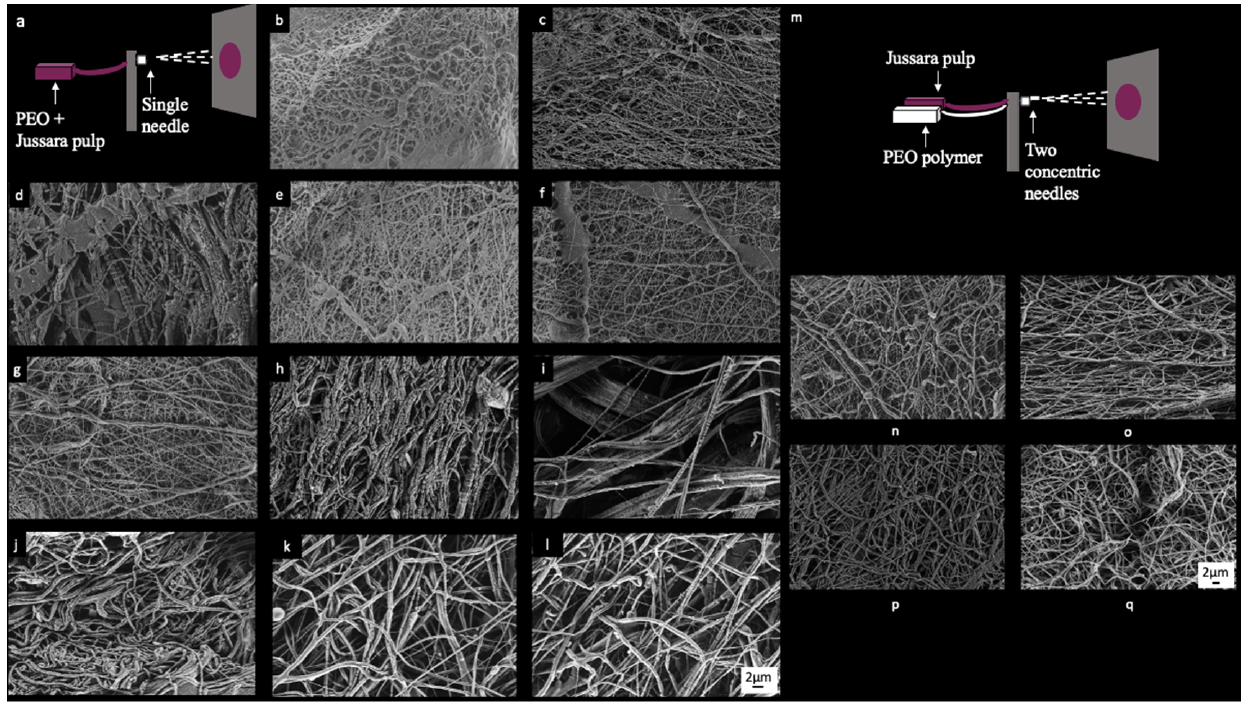
Figure 1. FE-SEM images electrospinning samples: ( a ) schematic view of uniaxial electrospinning, ( b ) sample 1 (6.3% PEO and 0.36% NaCl), ( c ) sample 2 (7.7% PEO and 0.36% NaCl), ( d ) sample 3 (6.3% PEO and 2.14% NaCl), ( e ) sample 4 (7.7% PEO and 2.14% NaCl), ( f ) samples 5 (6.0% PEO and 1.25% NaCl), ( g ) sample 6 (8.0% PEO and 1.25% NaCl), ( h ) sample 7 (7.0% PEO and 1.25% NaCl), ( i ) samples 8 (7.0% PEO and 1.25% NaCl), ( j ) sample 9 (7.0% PEO and 1.25% NaCl), ( k ) sample 10 (7.0% PEO and 1.25% NaCl), ( l ) sample 11 (7.0% PEO and 1.25% NaCl), ( m ) schematic view of coaxial electrospinning, ( n ) sample V1 (7.7% of PEO and 0.36% of NaCl), ( o ) sample V2 (8.0% of PEO), ( p ) sample V3 (7.7% of PEO and 0.36% of NaCl), and ( q ) sample V4 (8.0% of PEO).